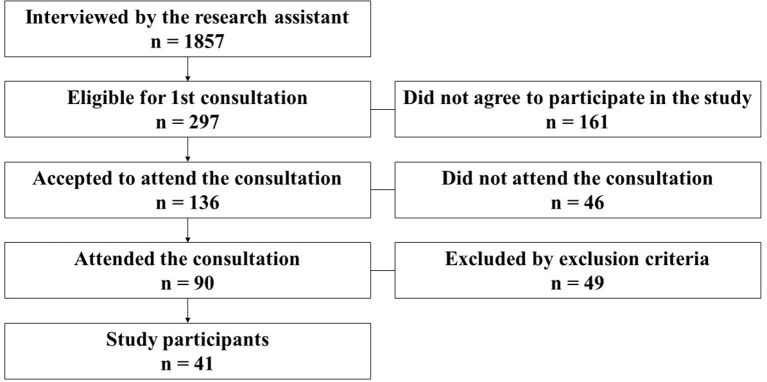
Study flowchart.